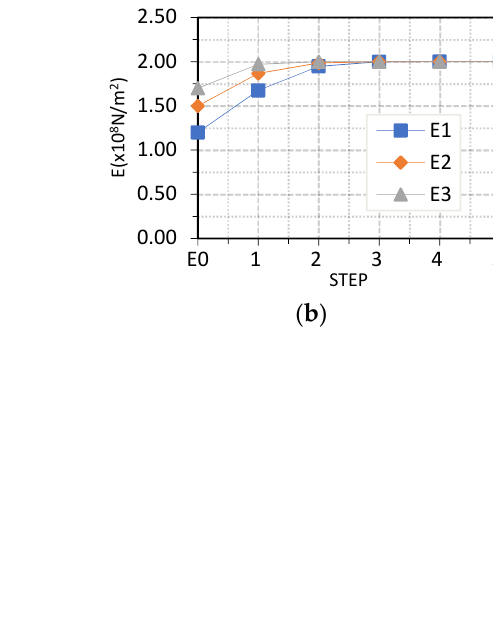
9 of 15 Table 4. Iteration results with different initial values. Set No.